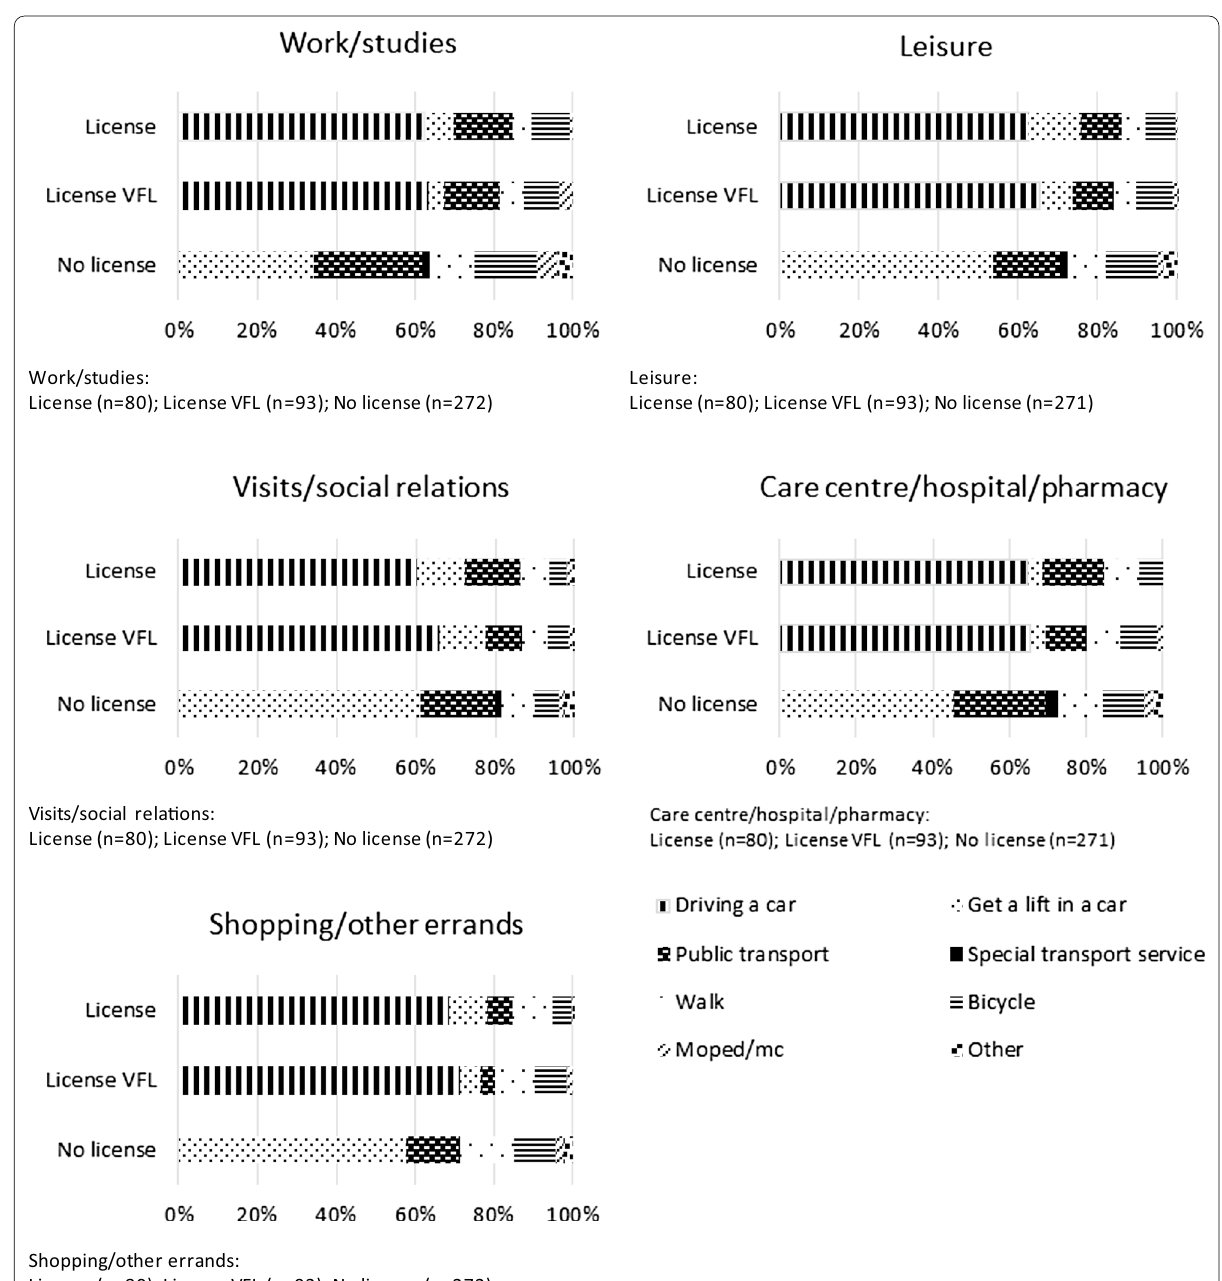
Fig. 1 Percentages of trips made by different transport means separated by type of